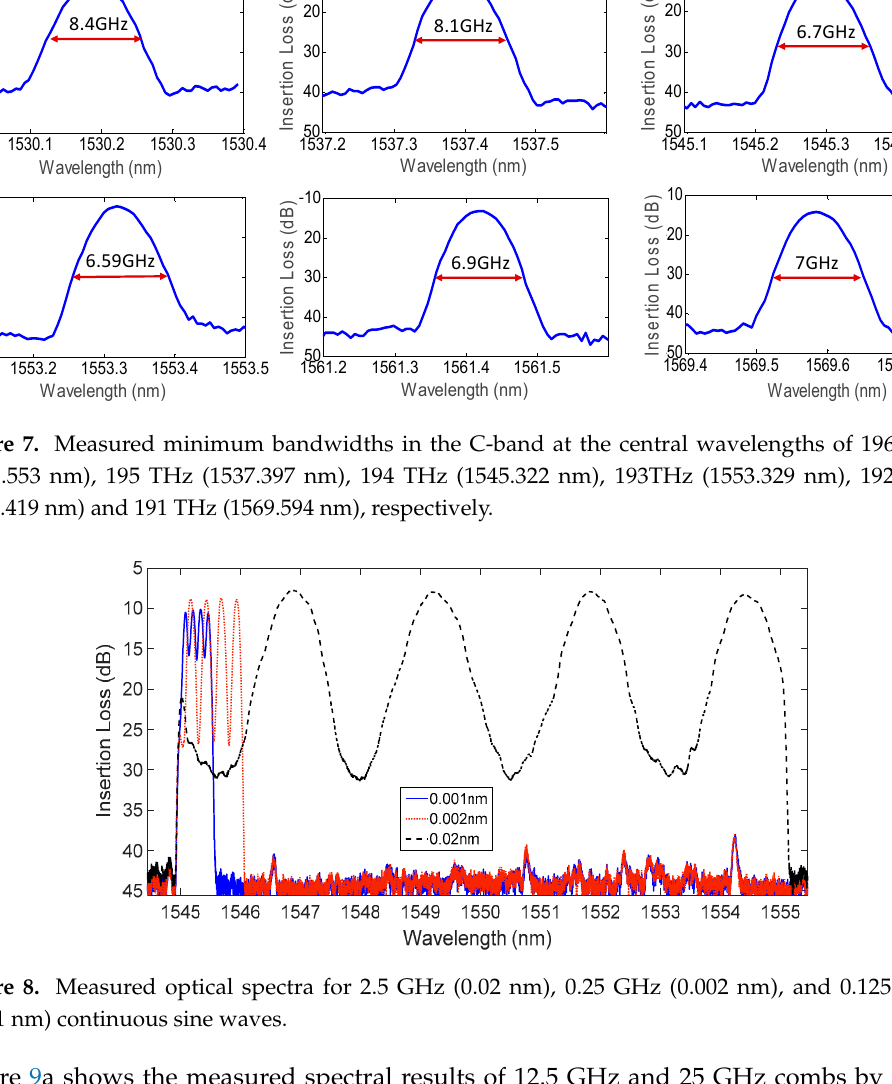
Figure 6. Flexible bandwidth adjustment with a minimum 3-dB bandwidth of 6.2 GHz to 25.3 GHz.